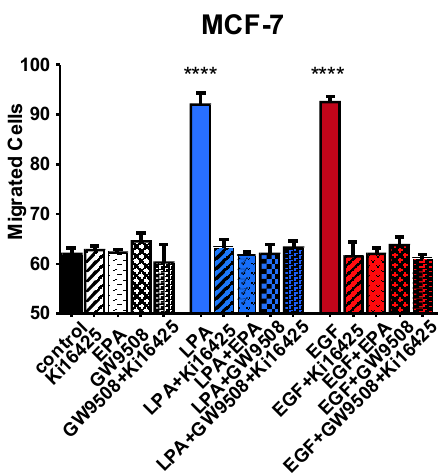
Figure 8. Effects of LPAR agonists on MCF-7 cell migration. Serum-starved MCF-7 cells were treated with 10 µ M Ki16425, 20 µ M EPA, 1 µ M GW9508, 10 µ M LPA, or 10 nM EGF, either alone or in combination. After a 6-h migration period, cells were analyzed as described in Methods. Each bar represents the mean ˘ SEM ( n = 4) of values (total number of migrated cells/well) obtained from two separate experiments, each of which used two separate replicate wells of cells for each experimental condition (**** p < 0.0001 vs. control). Data were analyzed using one-way ANOVA, followed by